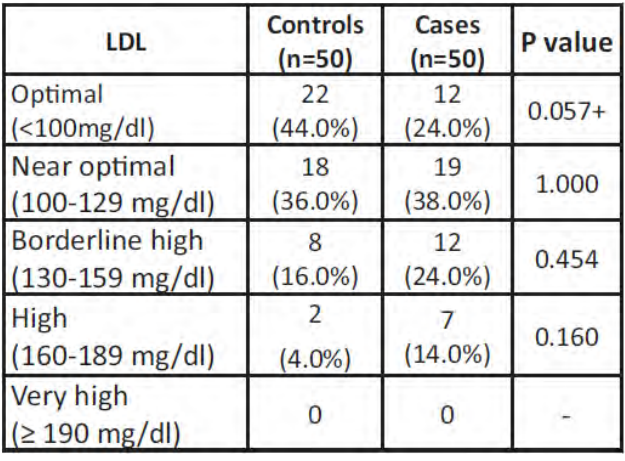
Table 5 shows a significant negative